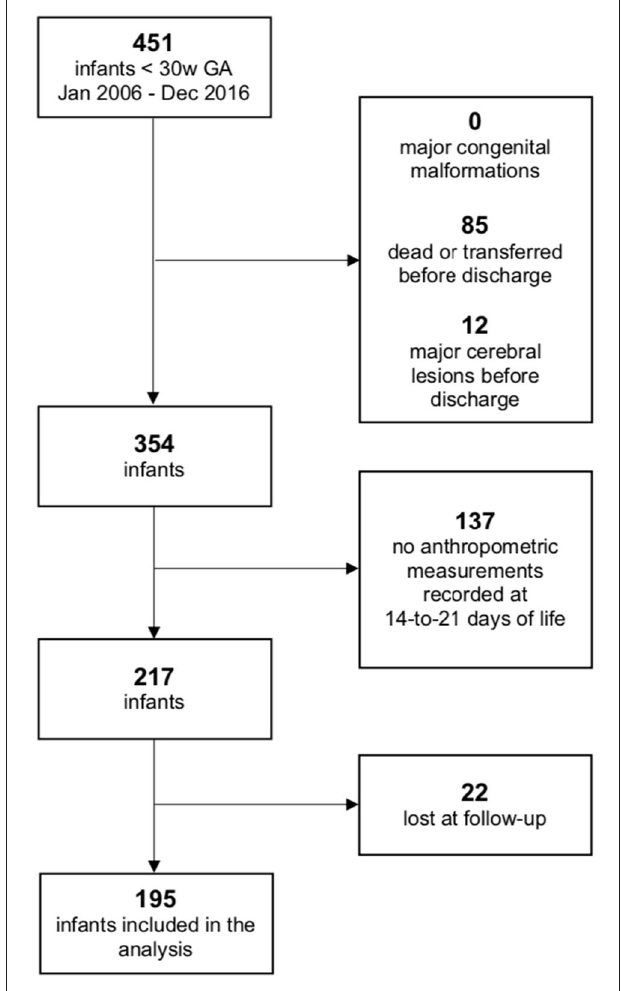
TABLE 1 | Clinical and anthropometric features of the study population ( N =